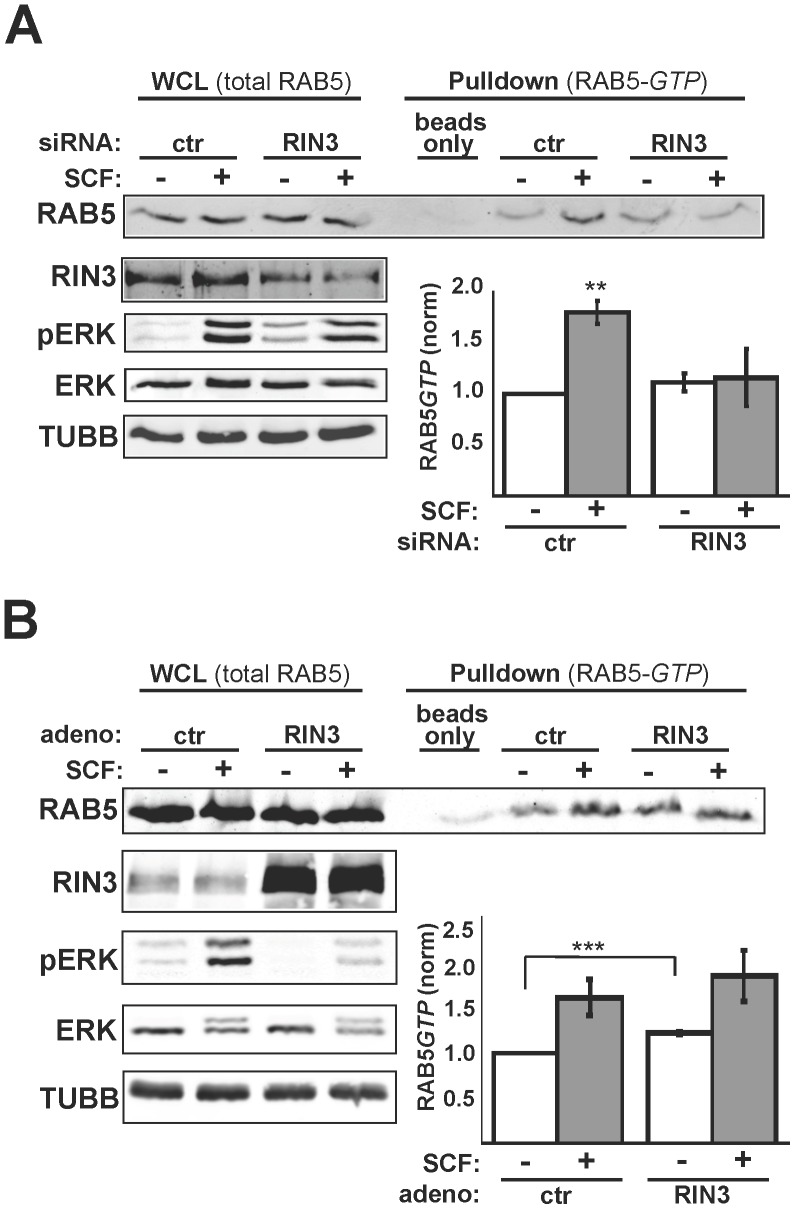
RIN3 promotes RAB5 activation. (A) LAD2 cells transfected with control or RIN3 siRNA were stimulated with 100 ng/ml SCF for 15 minutes. Cells were lysed and activated RAB5 was pulled down using 4X-ZFYVE-GST on glutathione beads as indicated in Methods. Precipitates from the beads were immunoblotted for RAB5 (RAB5GTP). The whole cell lysates were immunoblotted for total RAB5, RIN3, pERK (to show stimulation), ERK, and TUBB (loading control). Graph represents data from three independent experiments, **p<0.01. (B) Cells infected with Ad-GFP or Ad-RIN3 and treated as in (A). Graph represents data from three independent experiments, ***p<1 × 10−5.